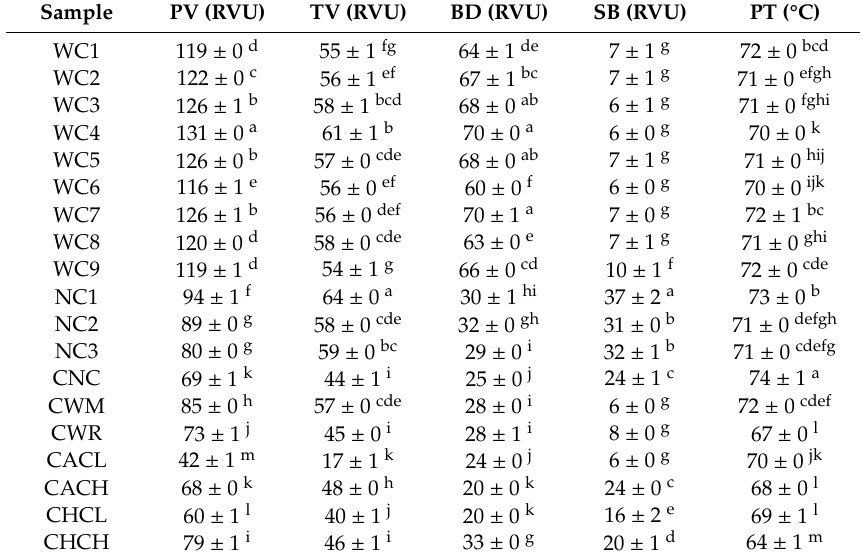
Results are mean ± S.D.; values followed by di ff erent superscripts within the same column are significantly di ff erent ( p ≤ 0.05). PV: peak viscosity; TV: trough viscosity BD: breakdown viscosity; FV: final viscosity; SB: setback viscosity; PT: pasting temperature.